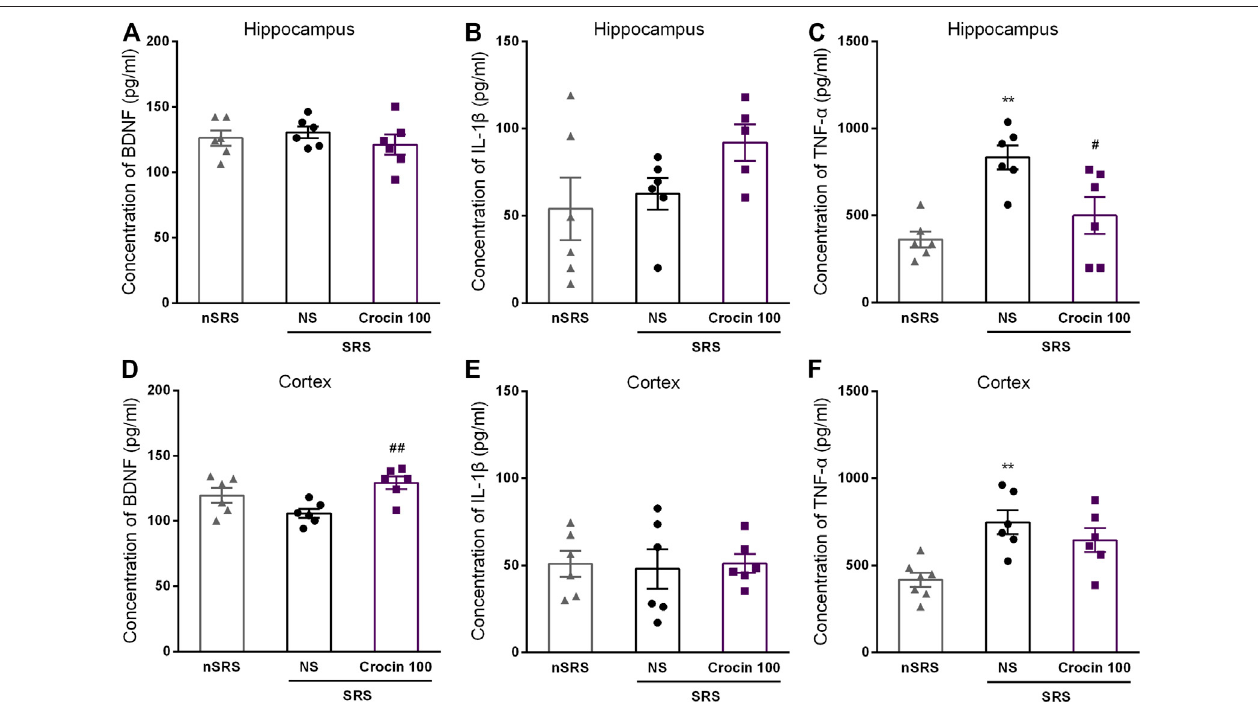
FIGURE7| EffectsofcrocinonintracerebralconcentrationofBDNF,IL-1 β andTNF- α ineachgroupofmice( n =6foreachgroup,x (cid:1) ±S.E.M.). (A) theconcentration of BDNF in the hippocampus of mice; (B) the concentration of IL-1 β in the hippocampus of mice; (C) the concentration of TNF- α in the hippocampus of mice; (D) the concentration of BDNF in the cortex ofmice; (E) the concentrationof IL-1 β in the cortex ofmice; (F) theconcentration ofTNF- α inthe cortex of mice.SRS,spontaneous recurrent seizures; nSRS, non-SRS; NS, normal saline; BDNF, brain derived neurotrophic factor; IL-1 β , interleukin-1 β ; TNF- α , tumor necrosis factor- α . Values are from3independentexperiments.** p < 0.01,comparedwithnSRSgroup;# p < 0.05,comparedwithNSgroup(withSRS).One-wayANOVAforrepeatedmeasureswas used followed by Tukey ’ s t-test for (A – F) .